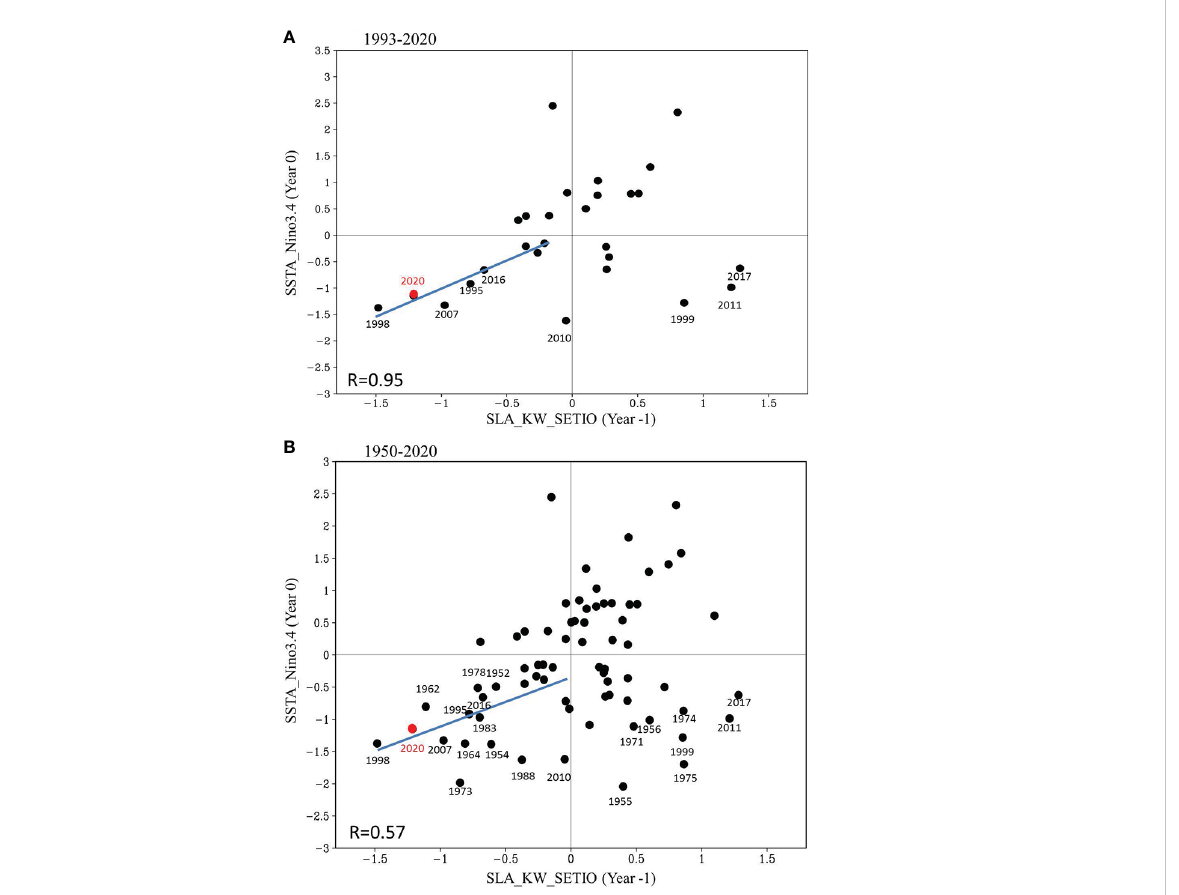
FIGURE 13 Application of the statistical model to longer SLA time series. (A) Scatter plot of the fall Niño3.4 index (°C) as a function of the fall SLA (decimeter) calculated from the wind-forced Kelvin wave (SLA_KW_SETIO) integrated along the pathway one year before during 1993-2020. Blue line denotes regressed linear relation between the fall SLA_KW_SETIO and the fall Niño3.4 index one year later. The value of 2010 is not included in calculating the blue line. (B) Same as in (A) , but for the period of 1950-2020. Correlation coef fi cients in the third quadrant are shown in the lower left of each